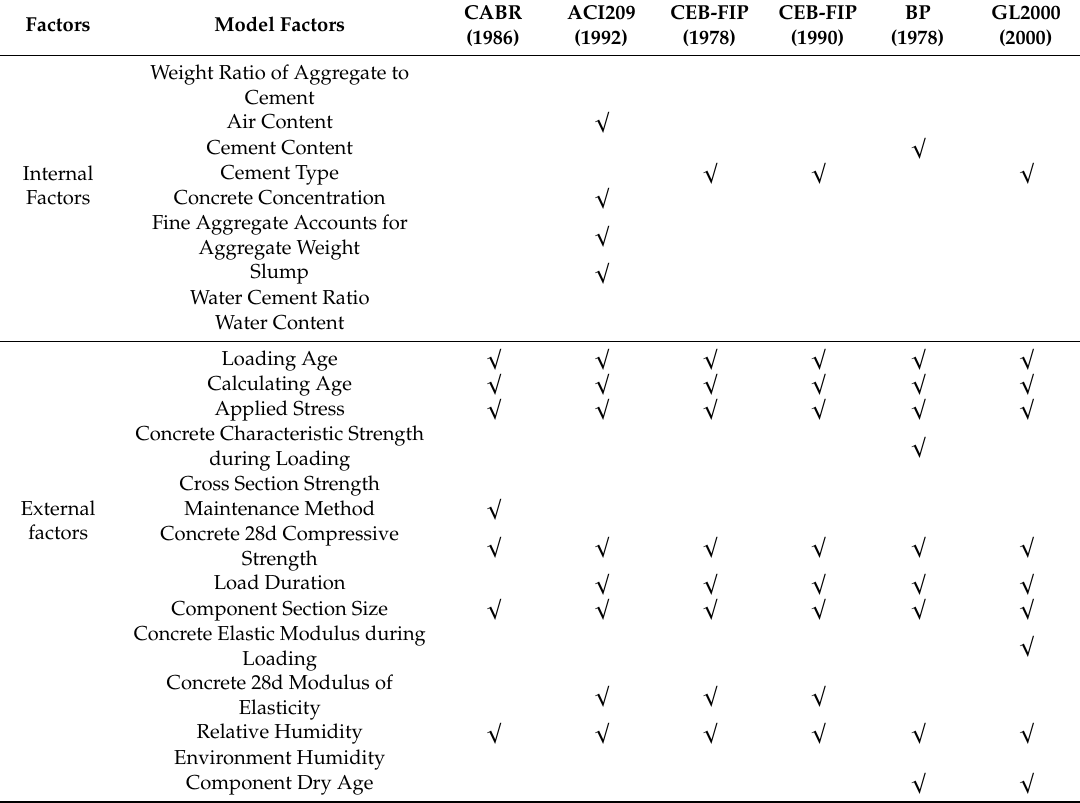
Table 7. Comparison of factors considered in common shrinkage and creep prediction